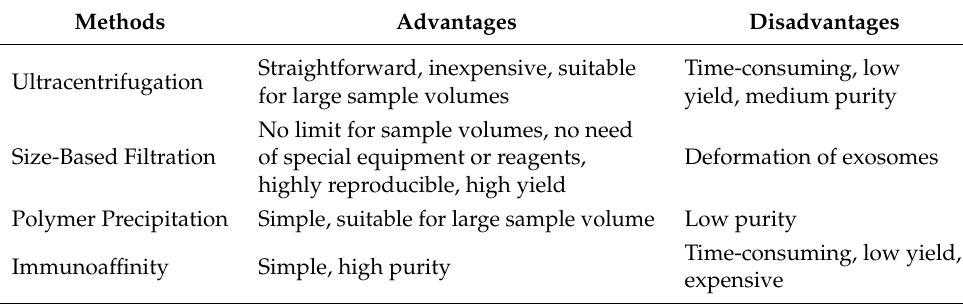
Table 1. Comparison of exosome isolation methods.